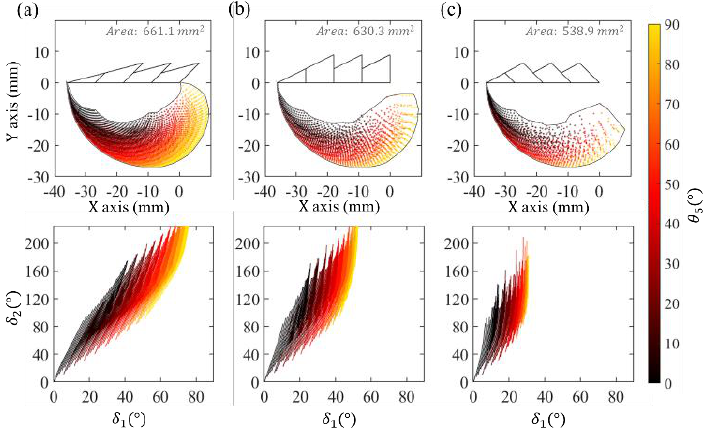
Figure 14. Scatter plots ( top ) and input – output angle relationships ( bottom ) of the triple four-bar linkage structures when h 1 = 1.0 L with different initial angle values ( a ) & 𝜓 = 45°, ( b ) & 𝜓 = 90°, and ( c ) & 𝜓 = 135°.